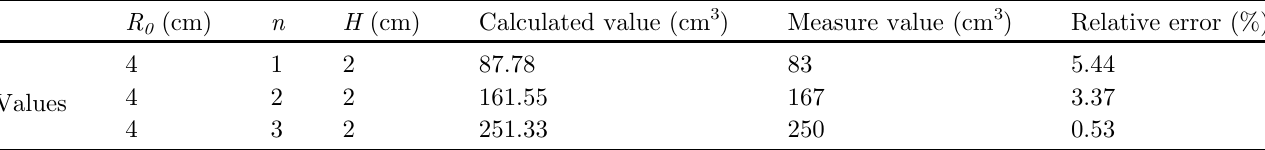
Table 8. Difference between calculated and measured values of